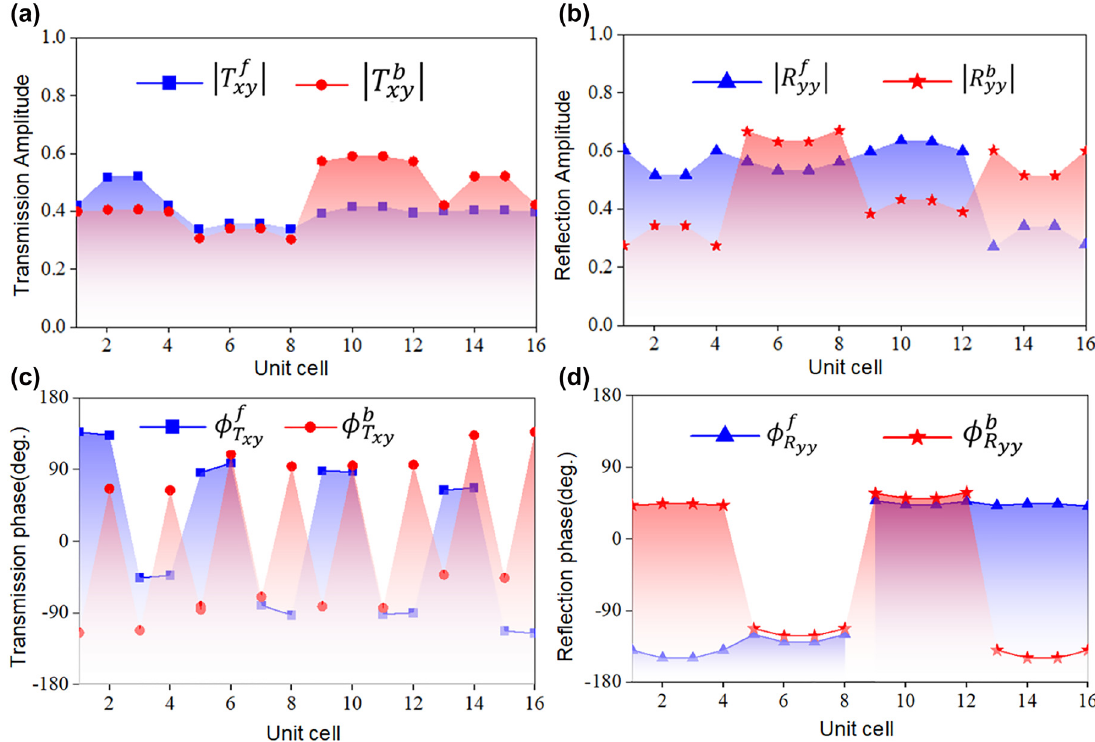
Figure 3: Characterization of the composite meta-atoms for reflection and transmission multitasking under y -polarized forward and backward illuminations. (a) Cross-polarized transmission and (b) co-polarized reflection amplitude responses. (c) Cross-polarized transmission and (d) co-polarized reflection phase